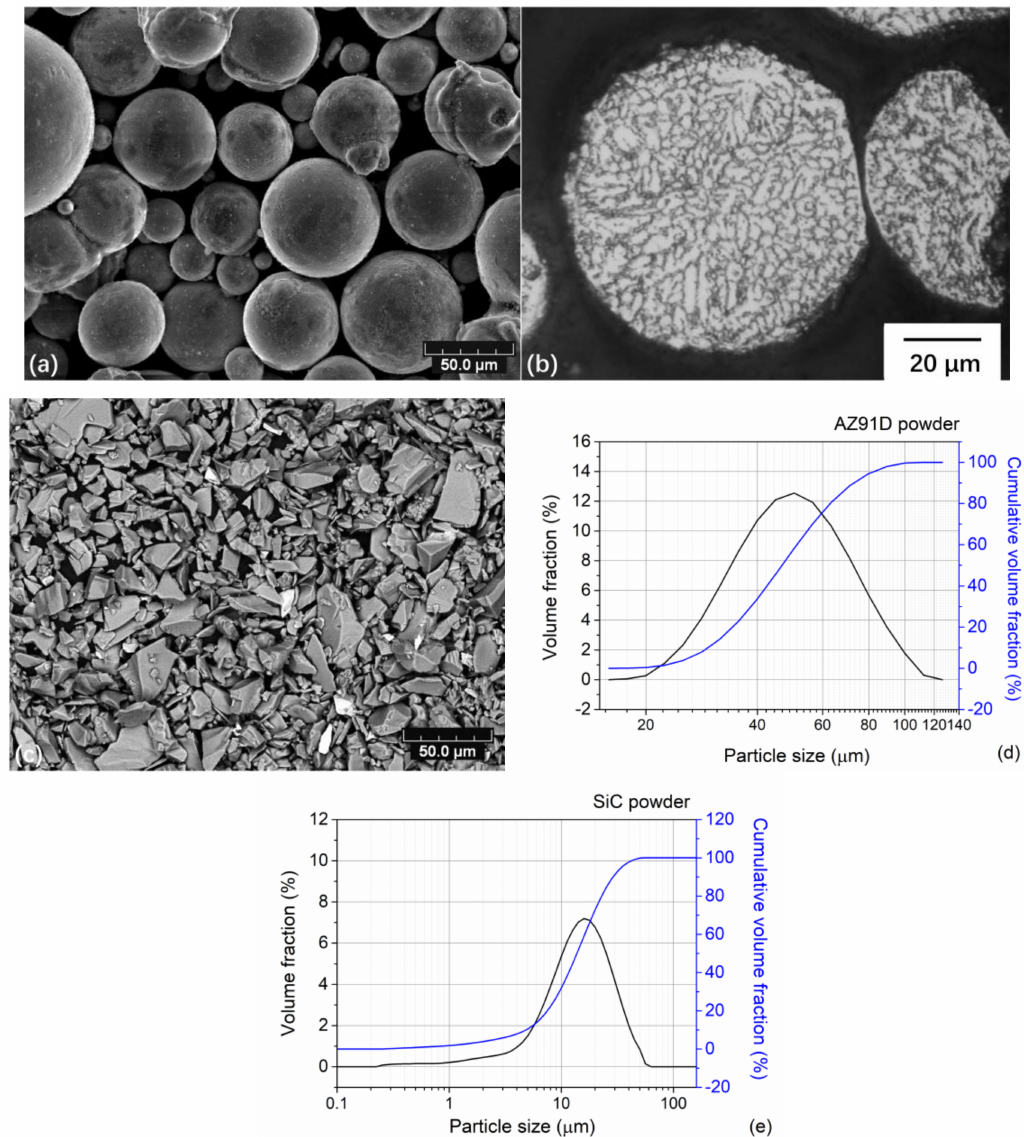
Figure 1. Morphology of the original AZ91D powder ( a ); sectional microstructure of an AZ91D particle after etching ( b ); and the morphology of SiC powder ( c ). Size distribution of the AZ91D powder particles ( d ) and SiC powder particles ( e